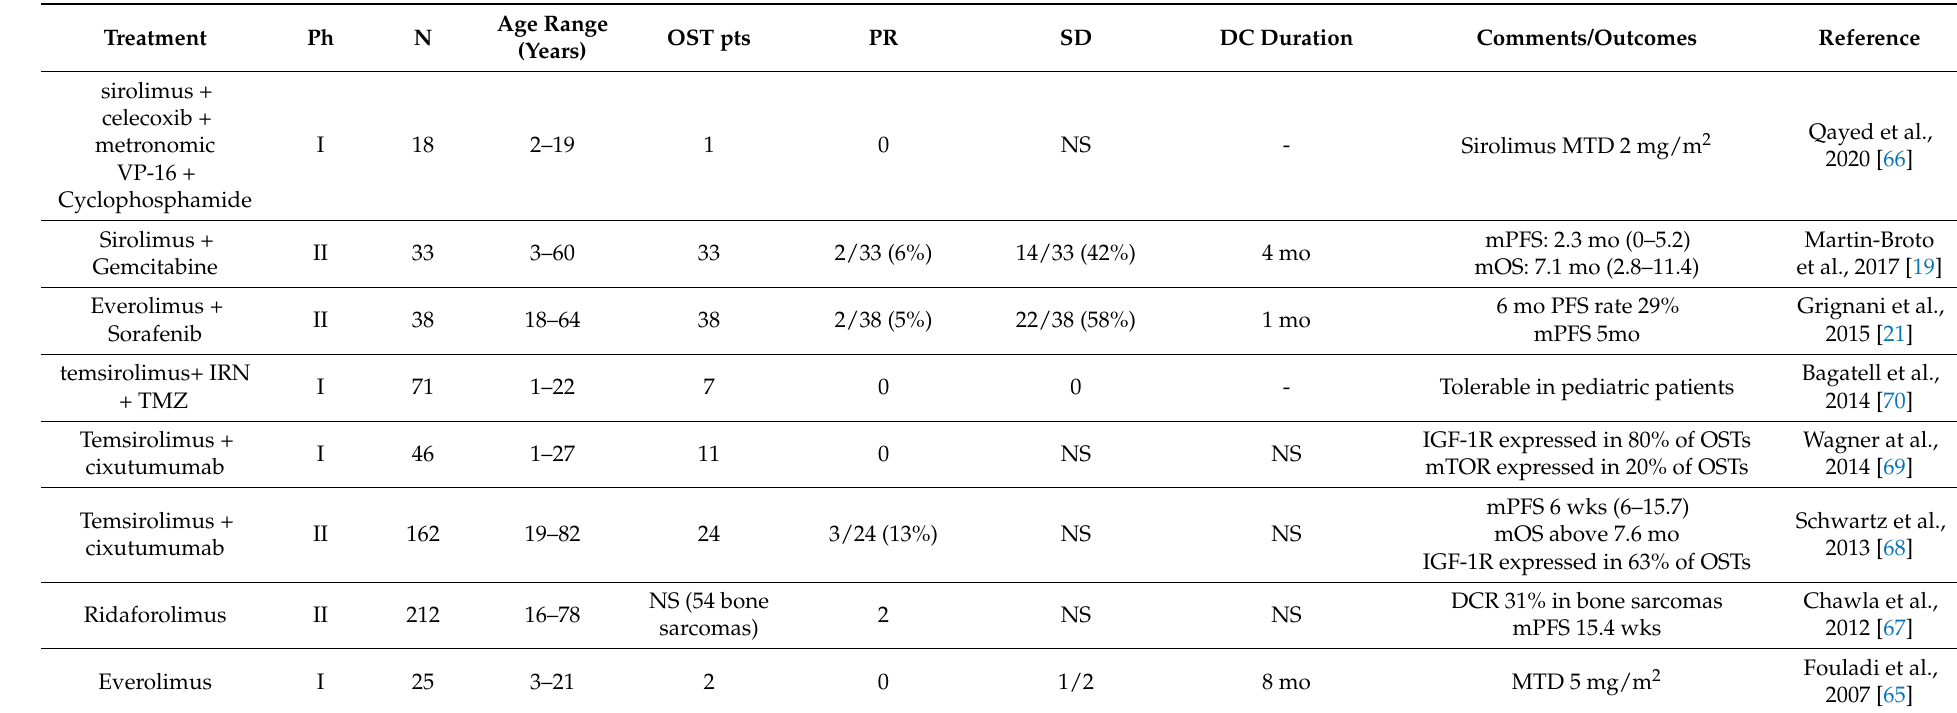
Table 3. mTOR inhibitors (8